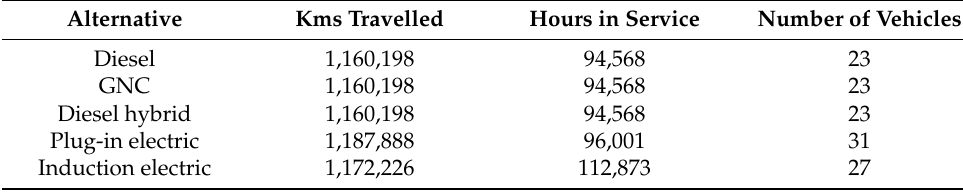
Table 6. Data on requirements by type of